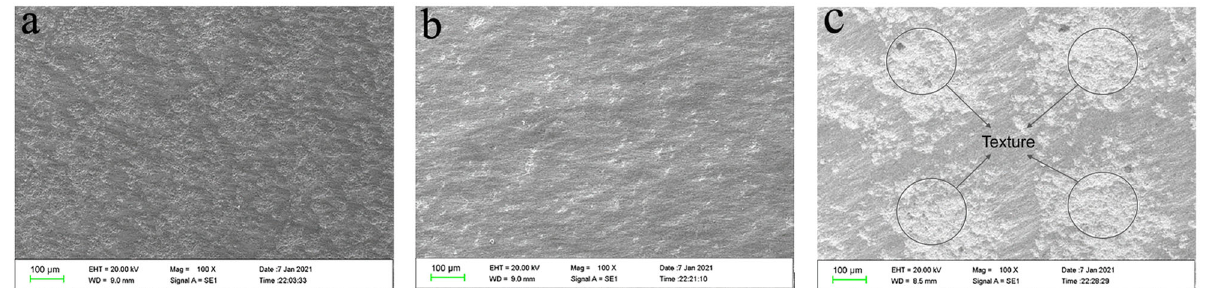
Figure 4. SEM of WC coating surface under different pretreatment processes. ( a ) Polished coating surface. ( b ) Sandblasted coating surface. ( c ) Textured coating surface.